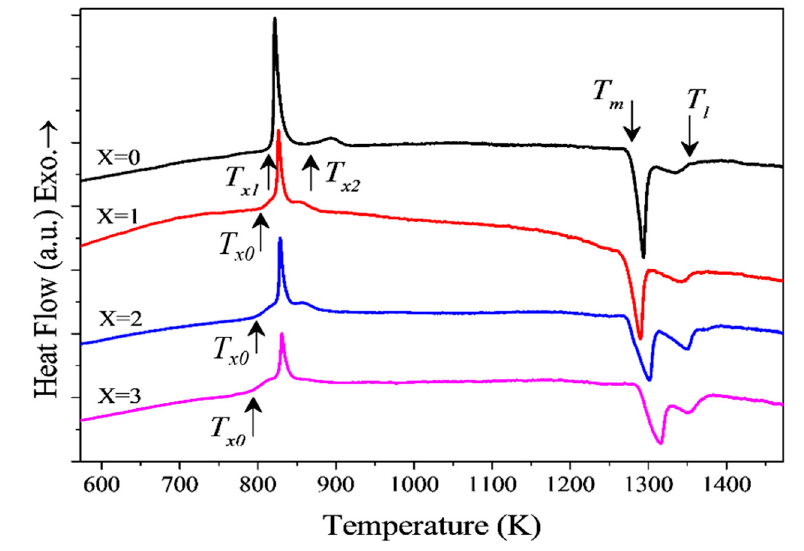
Figure 2. DSC curves of the as-spun Fe 76 Si 9 − x B 10 P 5 Mo x ( x = 0, 1, 2 and 3) ribbons with a heating rate of 20 K/min.